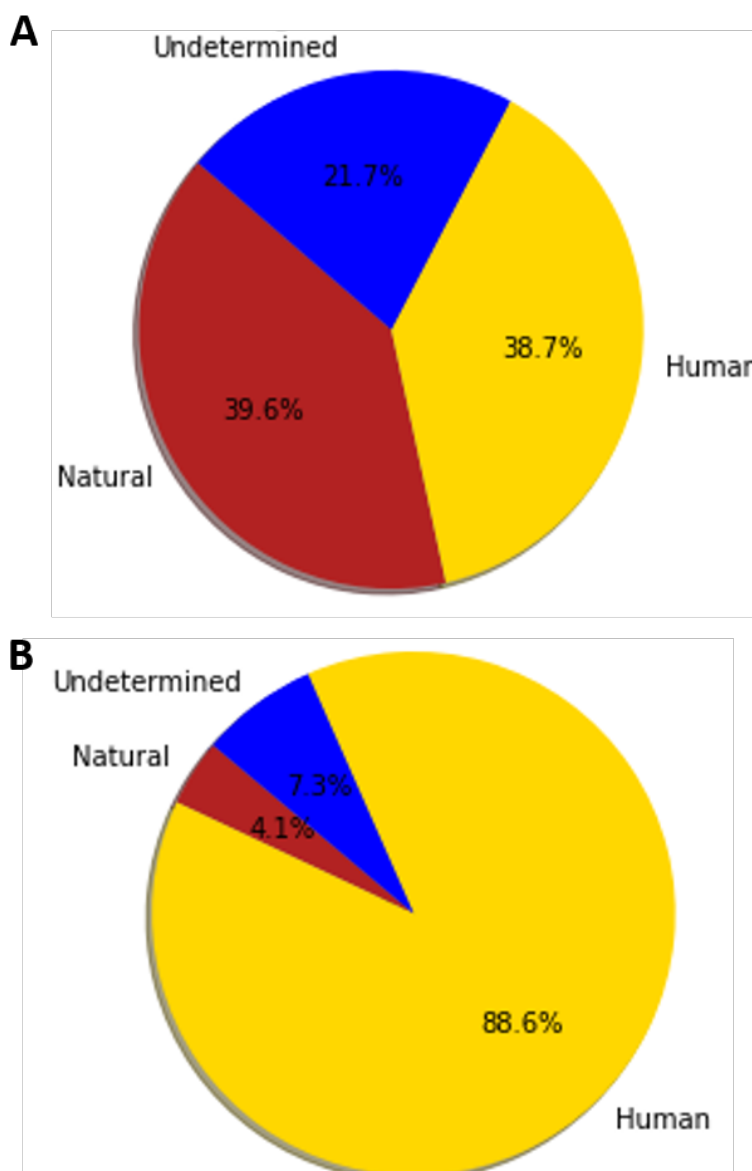
Figure A5. Causes of Wildfires between 2000 and 2018 for ( A ) the west and ( B ) northeast. More fires are due to natural causes in the eight cities analyzed for the west ( A ), while most fires are due to human causes in the eight cities analyzed for the northeast ( B